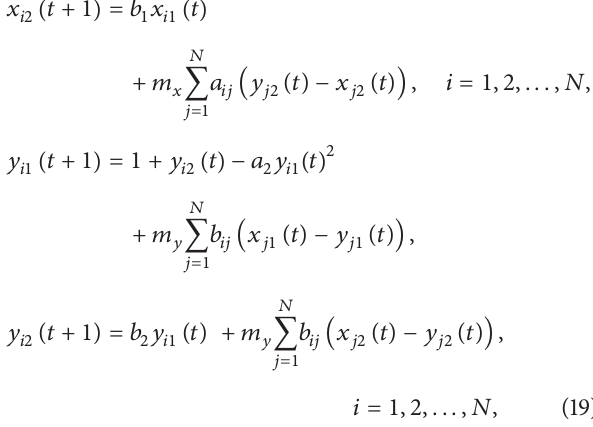
Figure 4: The trajectories of 𝐸 𝑥 , 𝐸 𝑦 , and 𝐸 𝑎 = 0.3, 𝑏 = 0.2 , and 𝑎 𝑏 2 with 1 1 = 0.3 𝑚 𝑦